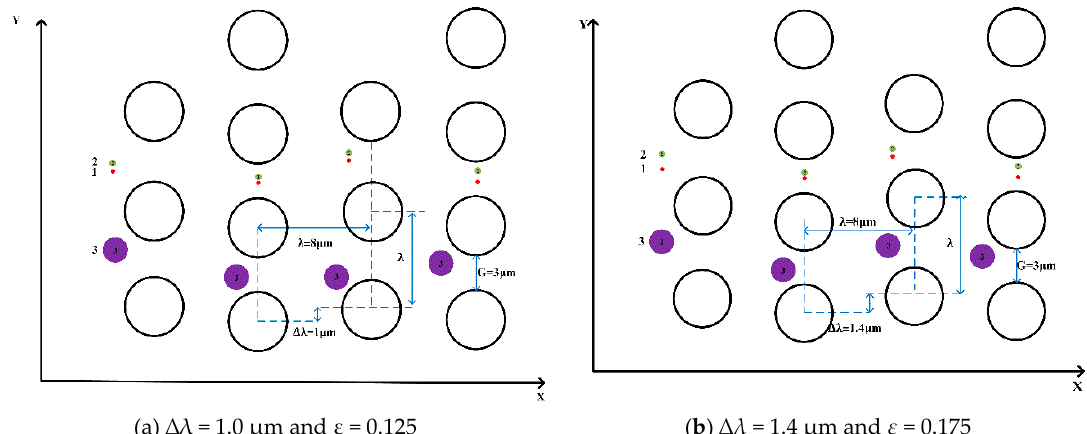
Figure 6. The trajectories of microspheres in a circular pillar array are in “displacement mode”. Marked with two fluid channels, the three microspheres in the channel (shown here in purple and red, respectively) are di ff erent in size. ( a ) The row shift is ∆ λ = 1.0 µ m and ε = 0.125. ( b ) The row shift is ∆ λ = 1.4 µ m and ε = 0.175.